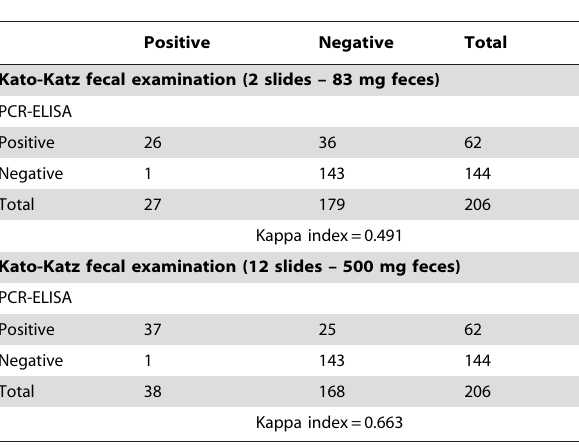
Table 1. Comparative evaluation of the Schistosoma PCR-ELISA system and the Kato-Katz technique for the diagnosis of S. mansoni